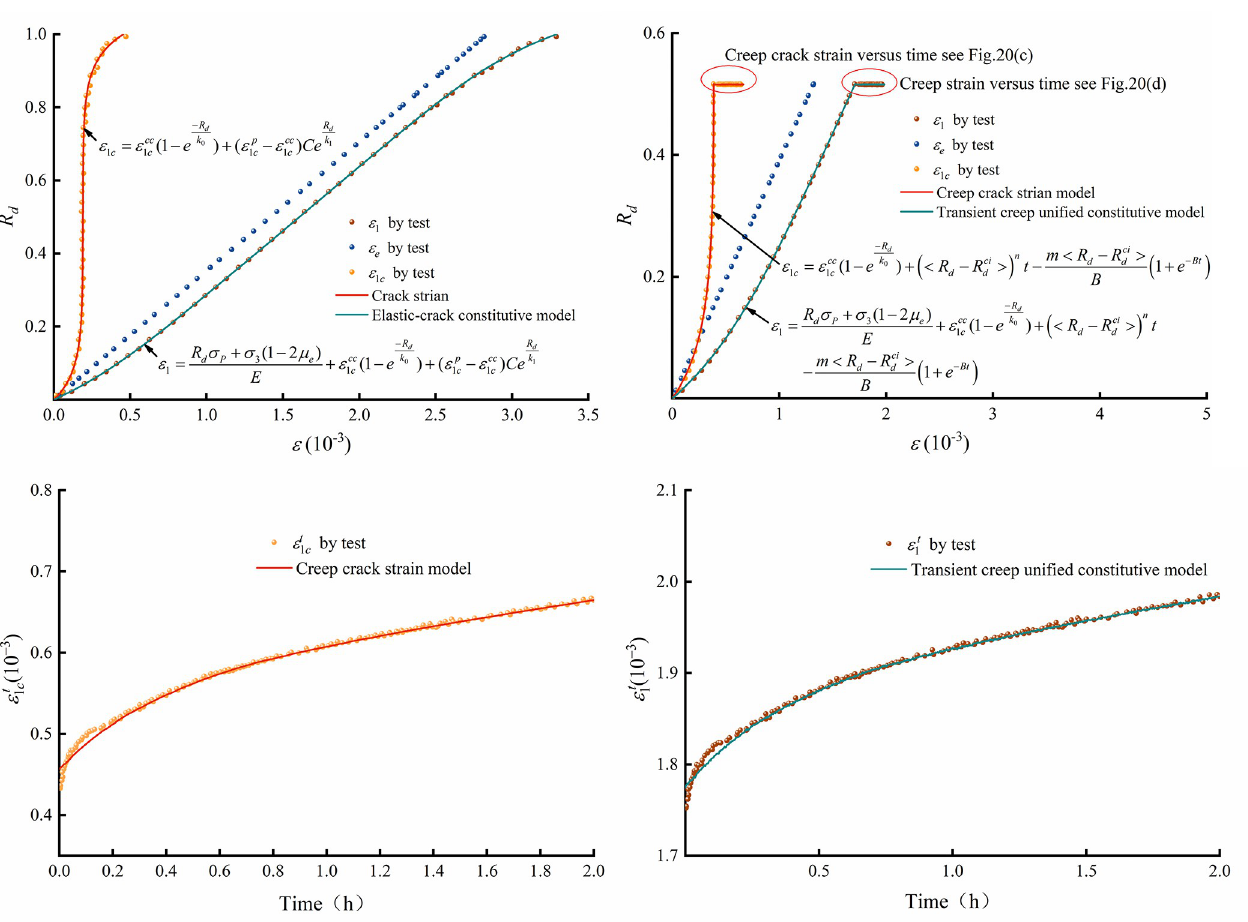
Fig 20. Application of the proposed constitutive models: (a) elastic-crack model, (b) transient creep unified constitutive model, (c) creep crack strain versus time and (d) creep strain versus time.